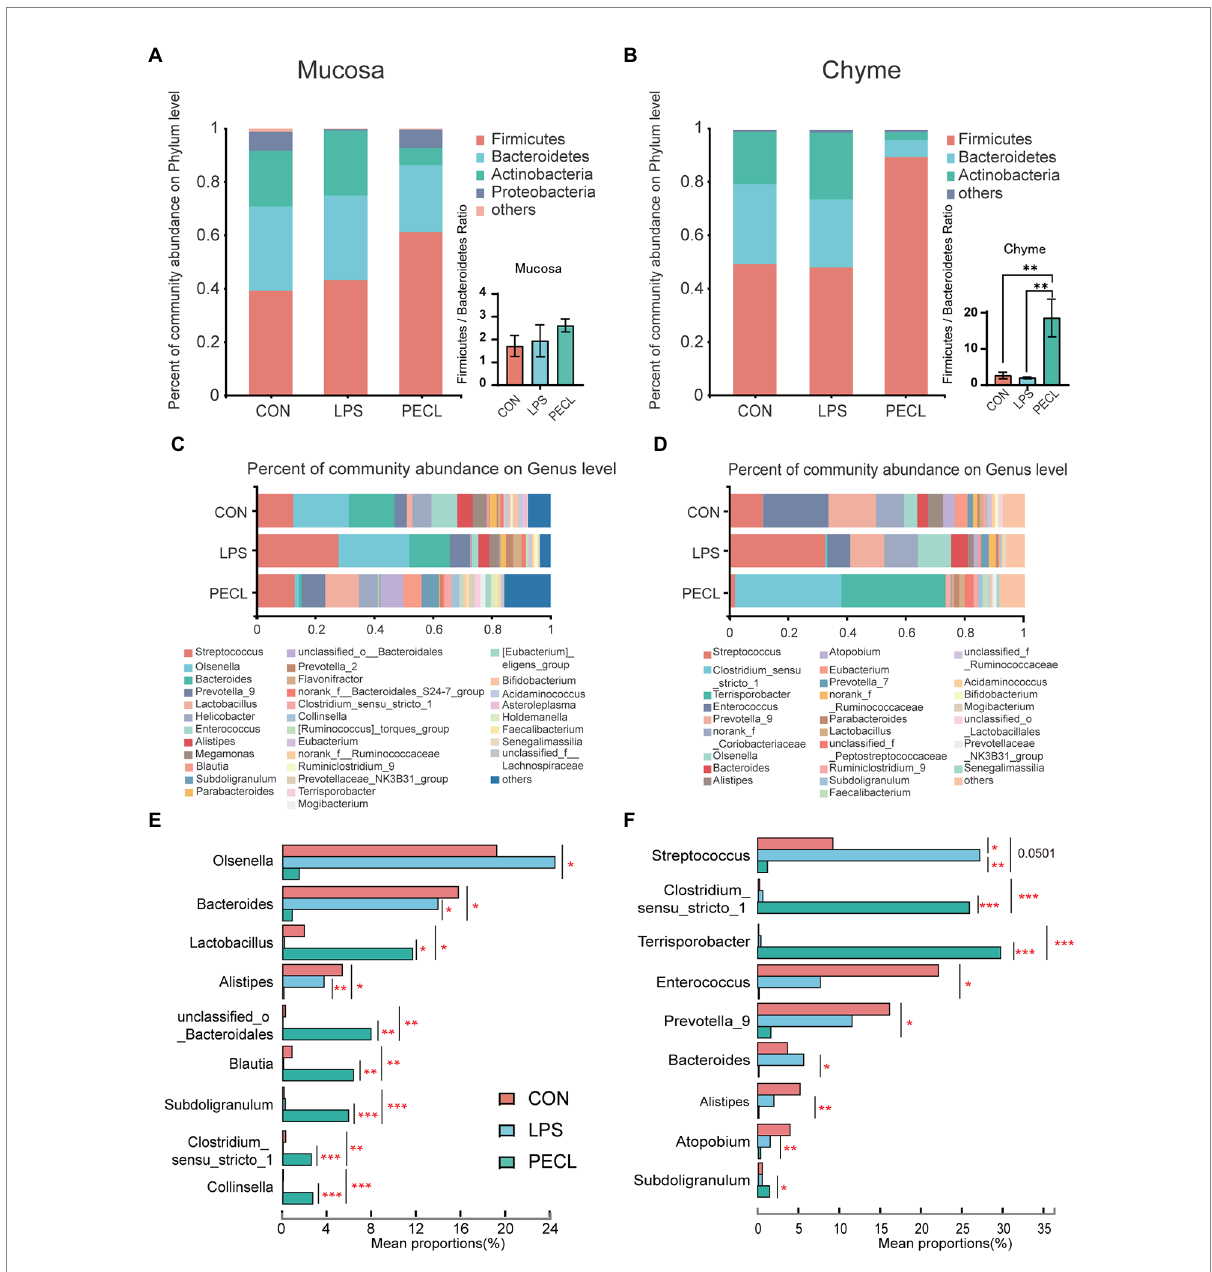
FIGURE 5 Pectin altered the cecum microbiota in LPS-challenged piglets. Structure comparison of intestinal microbiota in (A) mucosa and (B) chyme between CON, LPS and PECL groups at Phylum level and Genus level (C,D) . Kruskal–Wallis H test bar plot shows the changes in the intestinal microbiota in (E) mucosa and (F) chyme of piglets in different groups at the genus level. Signification is presented as * p < 0.05, ** p < 0.01, and *** p < 0.001; data are presented as the mean ± SE ( n =